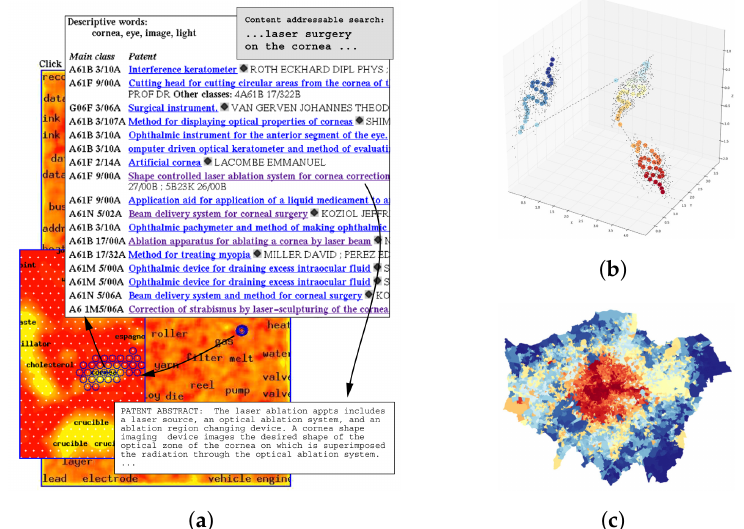
Figure 8. ( a ) Reprinted from [128], Copyright (2013), with permission from Elsevier. The document map of nearly 7 million patent abstracts (background). Twenty best-matched nodes are marked for the query “laser surgery on the cornea” (blues circles within the enlarged map). ( b ) Reprinted from [130], Copyright (2017), with permission from Elsevier. One-dimensional SOM with 100 nodes, trained with a three-dimensional data set: the final weight vectors of the trained SOM are color-coded based on their index numbers from 1 to 100. ( c ) Reprinted from [130], Copyright (2017), with permission from Elsevier. Contextual map of London based on the average working hours, the average distance traveled to work, and the average age within each